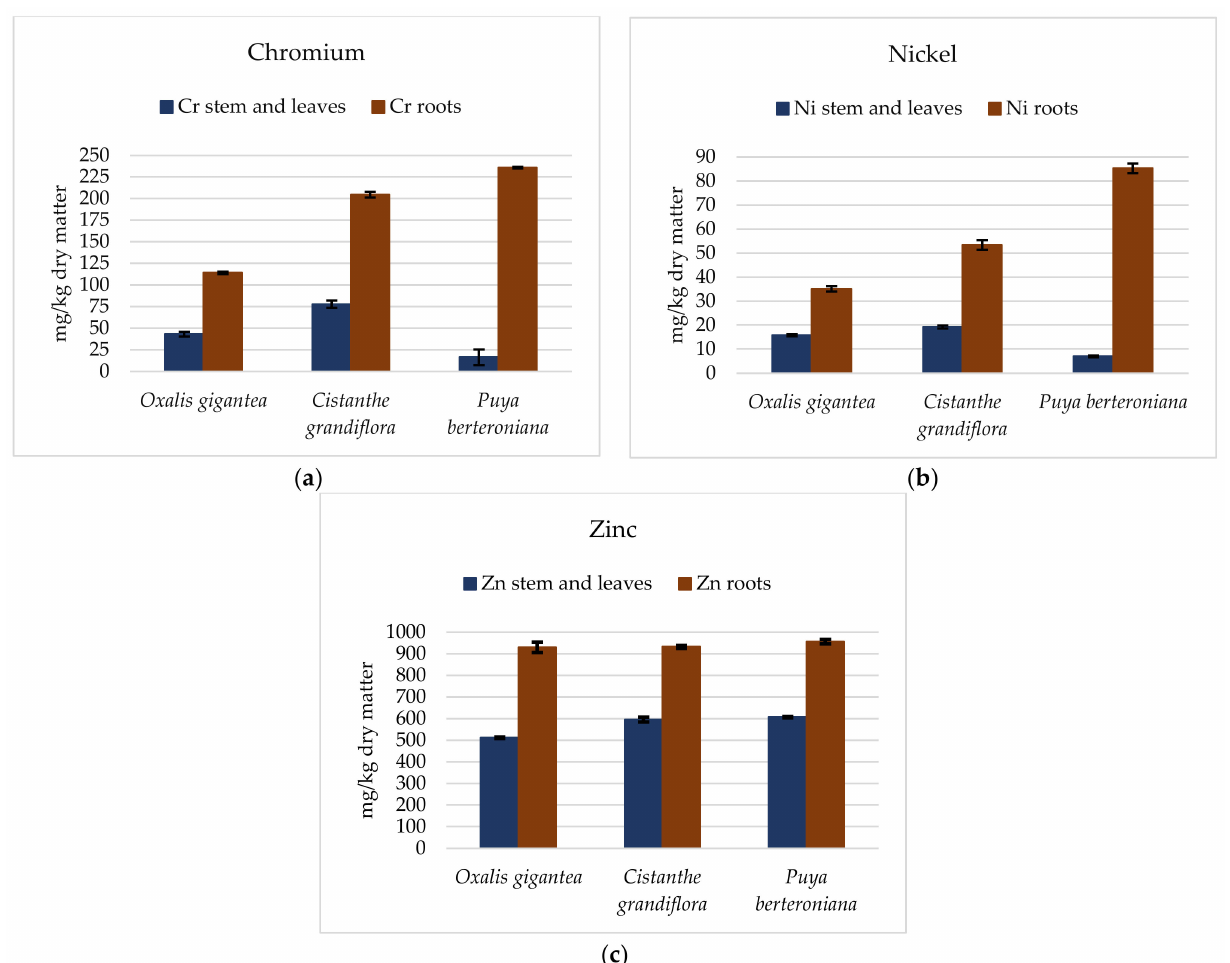
Figure 2. Metal content in studied plant species. Values are mean ± standard deviation. ( a ) Cr in stems and leaves, and roots; ( b ) Ni in stems and leaves, and roots; ( c ) Zn in stems and leaves, and